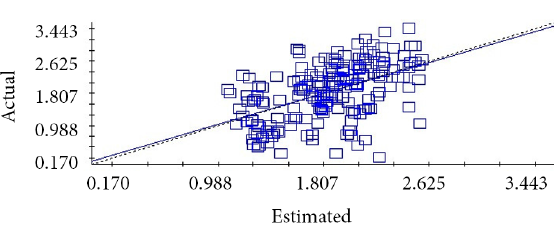
Fig. 6. Validation of PI distribution estimation by Kriging